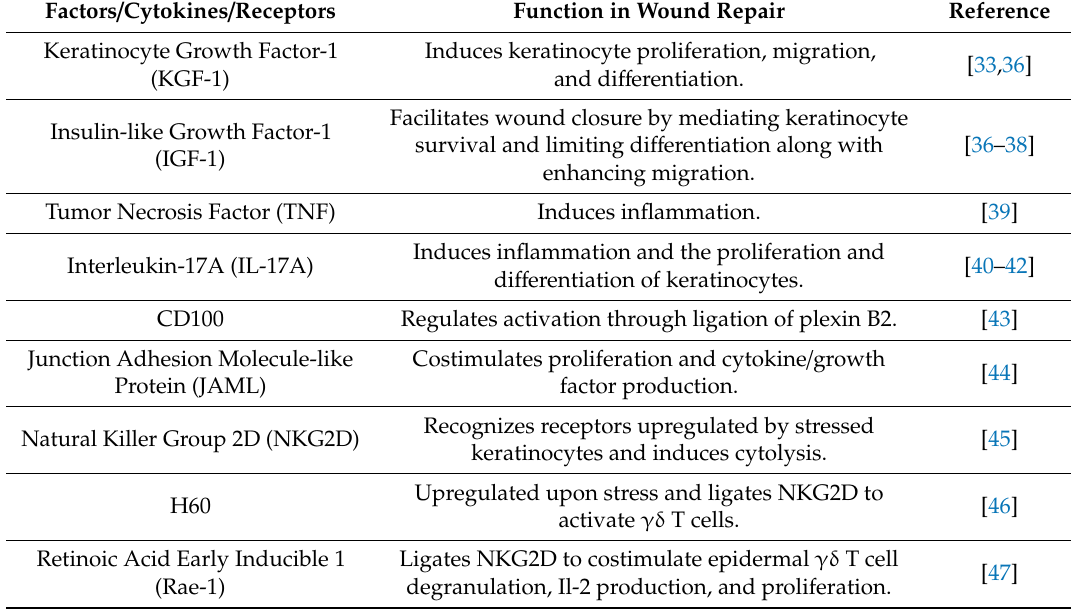
Table 1. Factors, cytokines, and receptors that regulate and are regulated by γδ T cells in the skin. Factors / Cytokines / Receptors Function in Wound Repair